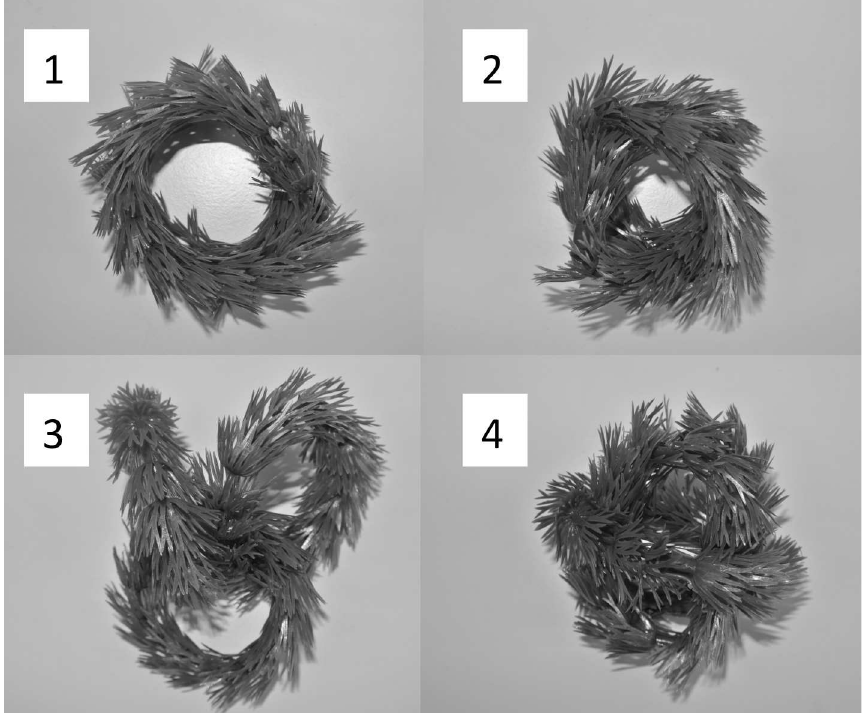
Fig 1. Photographs of the structures used to create habitat complexity in microcosms with ‘structure present’. The basic unit of each structure was a plastic plant strip (mimicking Ceratophyllum spp.), joined up as a ring (~ 8cm in diameter) and four levels of fractal dimensionwere created with them: 1) level 1 consisted of two rings aligned,with a fractal dimension (D) of 1.77; 2) level 2 consisted of two rings twisted into each other (D = 1.80); 3) level 3 consisted of three rings locked together (D = 1.81) and 4) level four was a ball made from 3 rings together (D = 1.83). This design therefore also gave two levels of ‘amount of structure’ - 3 g for complexity level 1 and 2 and 4.5 g for complexity level 3 and